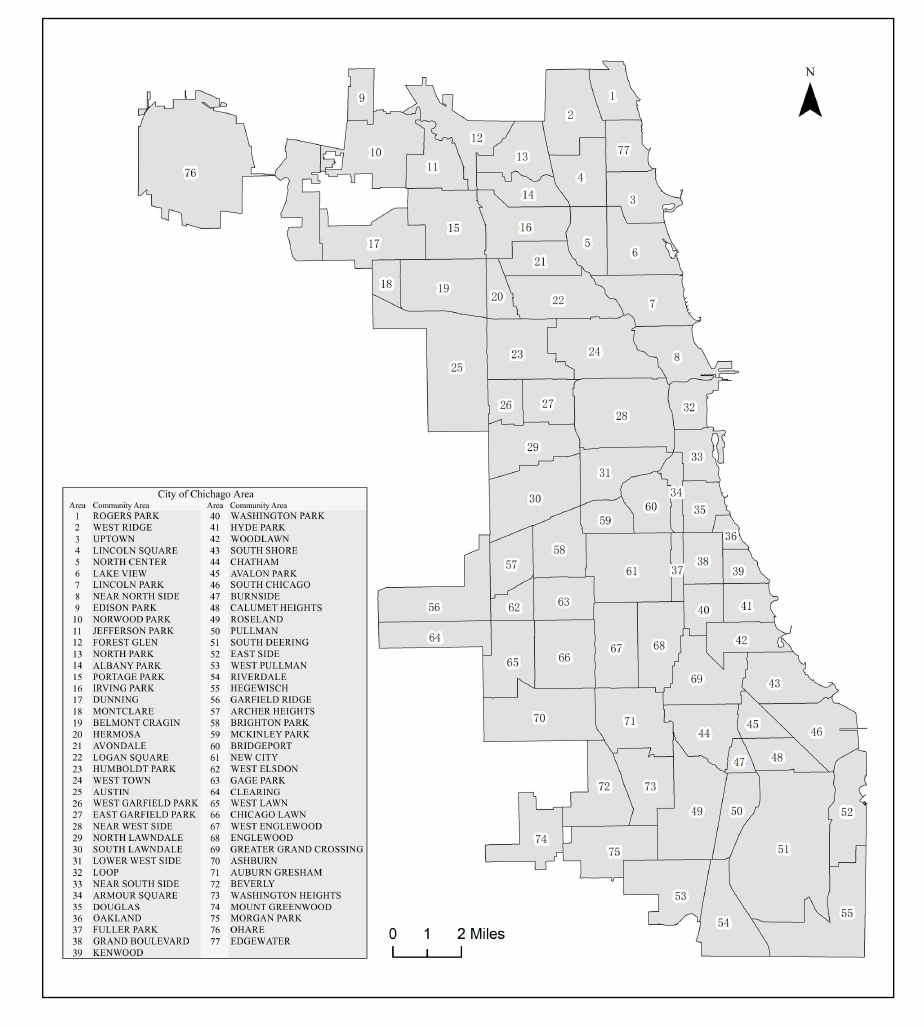
Figure 2. Community areas of Chicago. The black label is the code of each community area. Left table showed the community’s name of each